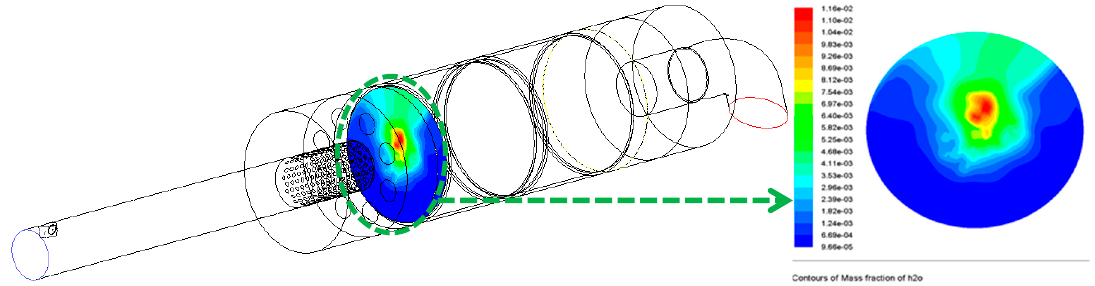
Figure 6. NH 3 distribution uniformity of the inlet face of the SCR catalyst (Uniformity Index = 0.58, Operation Points 1).